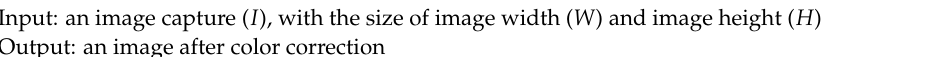
Algorithm 1: Proposed color correction algorithm (Pseudocode)